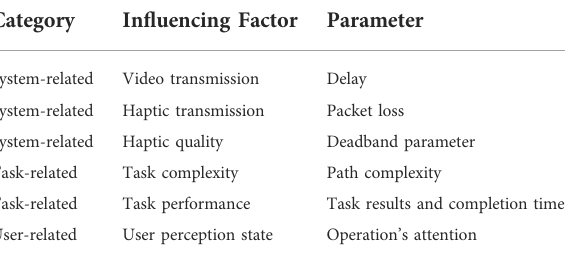
TABLE 1 The key QoE in fl uence factors.